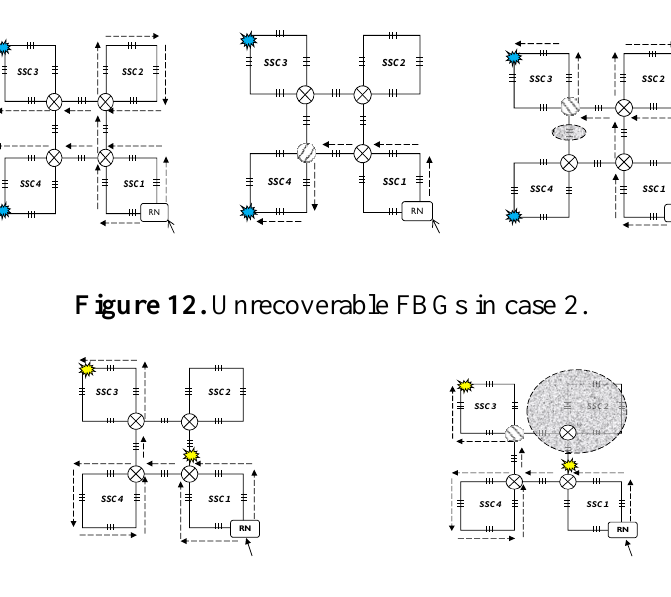
Figure 11. Unrecoverable FBGs in case 1.